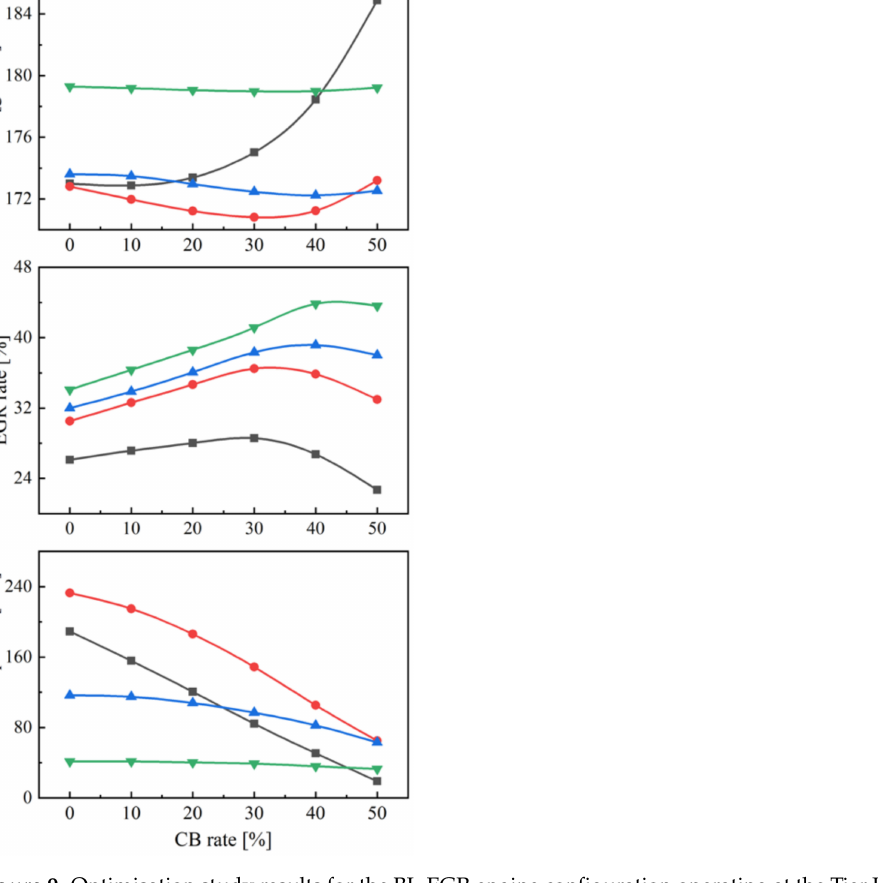
Figure 9. Optimisation study results for the BL-EGR engine configuration operating at the Tier III